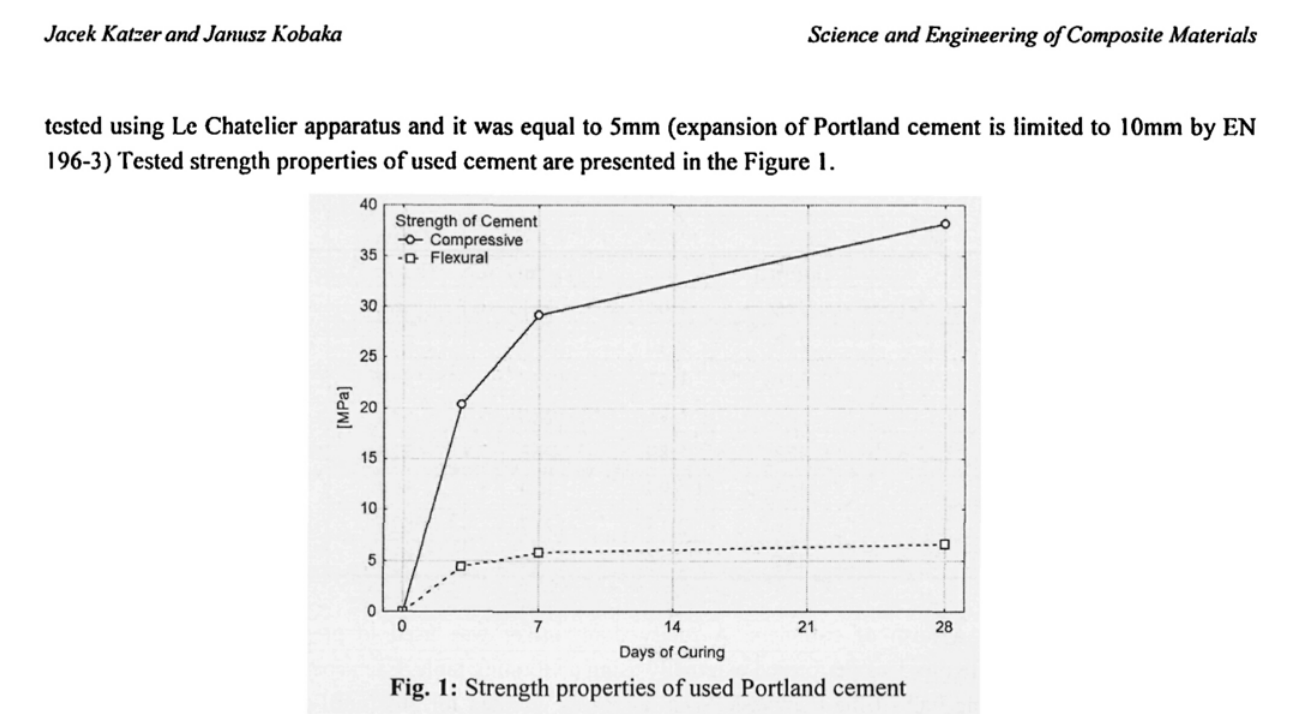
Fig. 1: Strength properties of used Portland cement